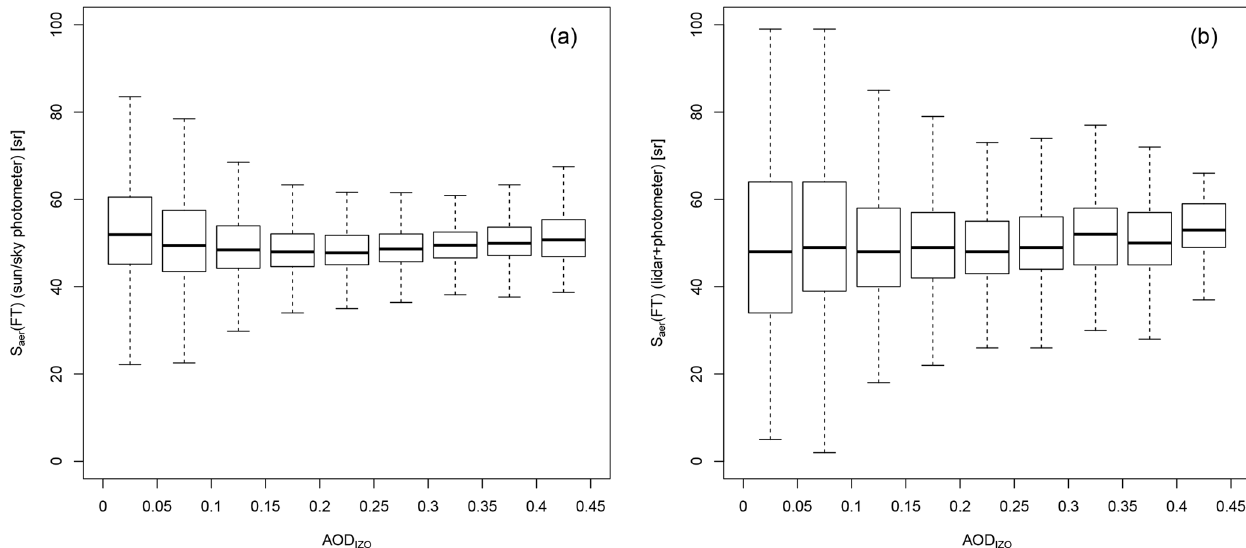
Figure 16. Lidar ratios at 523nm obtained from (a) the sun–sky photometer installed at Izaña and from (b) two-layer inversion for the FT for different AOD IZO intervals. The central rectangles extend from the first quartile to the third quartile and the median is represented by a horizontal line. The whiskers are defined as the upper and lower quartiles ± 1 . 5IQR (interquartile